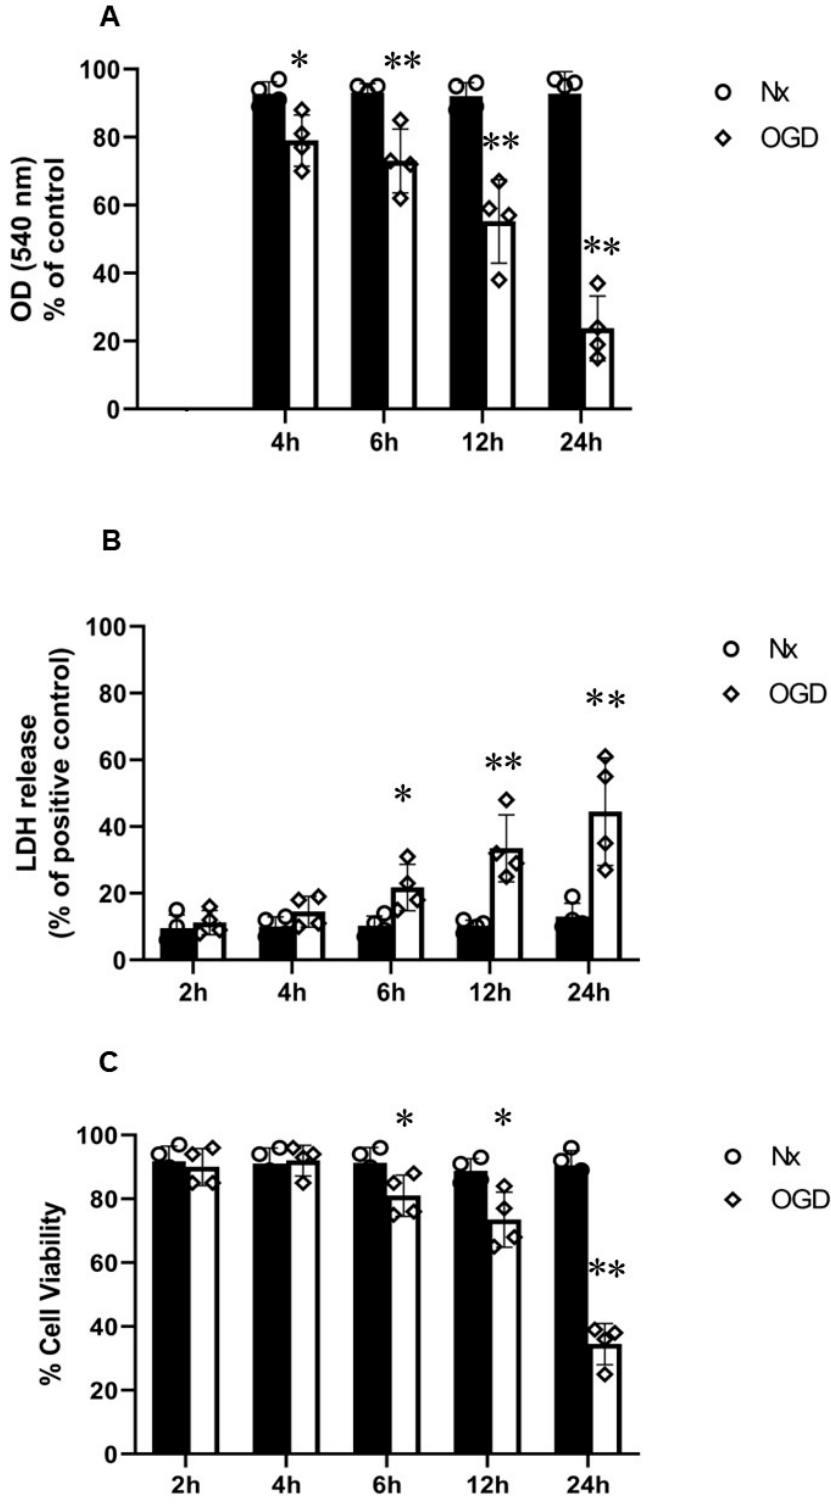
Figure 1. PC12 cells in normoxia (Nx) and subjected to oxygen–glucose deprivation (OGD). ( A ) MTT assay ( n = 4) showed a significant reduction in MTT activity over time in cells subjected to OGD; ( B ) LDH assay ( n = 4) showed a significant increase in LDH release in cells subjected to OGD from 6 h OGD onwards; ( C ) trypan blue exclusion assay ( n = 4) showed a significant reduction in % of live cells from 6 h OGD onwards. Error bars represent ± S.D. * Indicates p < 0.05, ** p < 0.01, compared to Nx